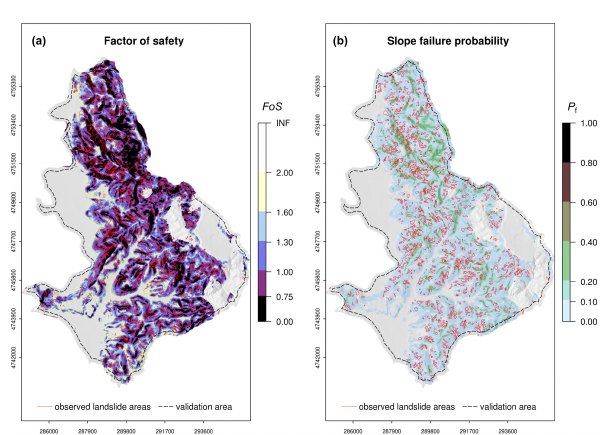
Figure 8. Spatial patterns of shallow slope stability in the Col- lazzone study area, computed with r.slope.stability applying equal density sampling (strategy c). (a) FoS for d e = 2500. (b) P f for d e = 2500 and n = 9 3